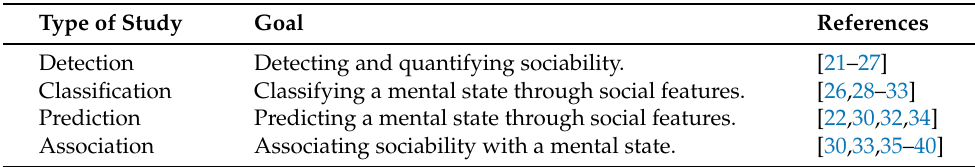
Table 1. Categorization of related works. Type of Study Detecting and quantifying